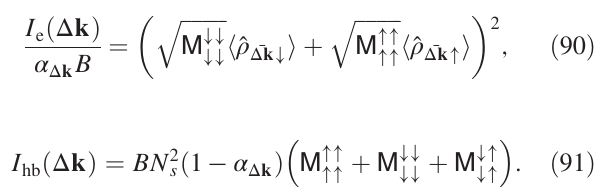
Fig. 7. The atoms in j ↓ i undergo a cycling transition, in which case they are only excited to j 1 i , decaying back to